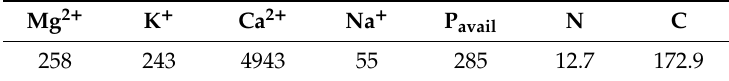
Table 1. Depth-integrated (0–40 cm) nutrient stocks in the experimental field in kg ha − 1 except for N and C, which were measured as t ha −